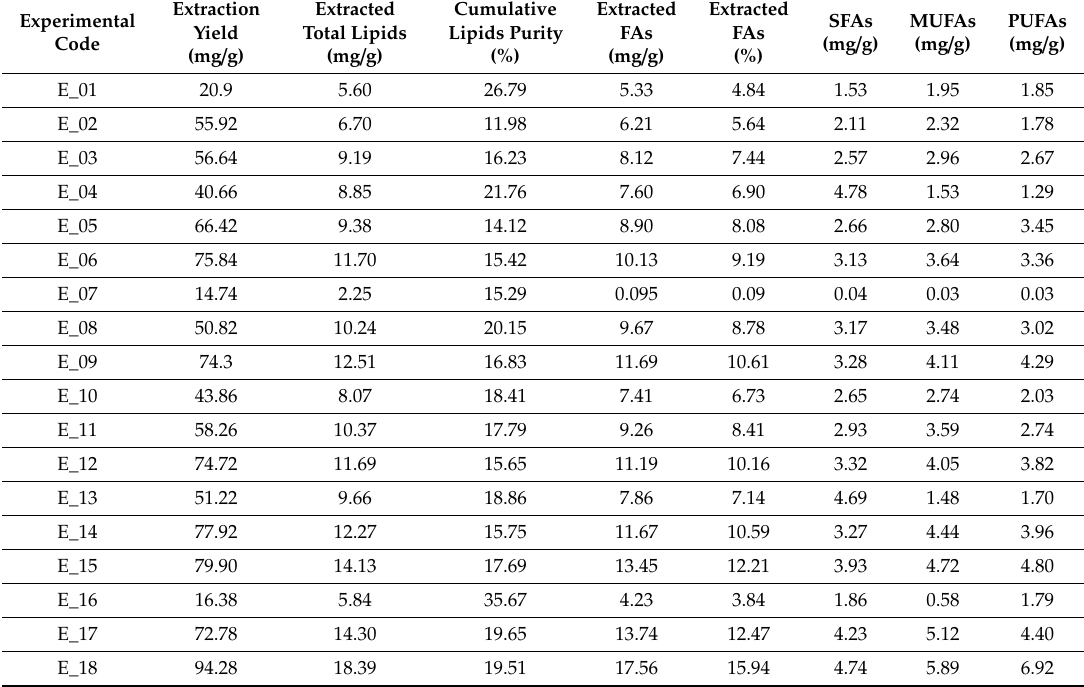
Table 1. E ff ect of supercritical fluid-carbon dioxide (SF-CO 2 ) extraction conditions on extraction yield and lipid recovery from Nannochloropsis sp.